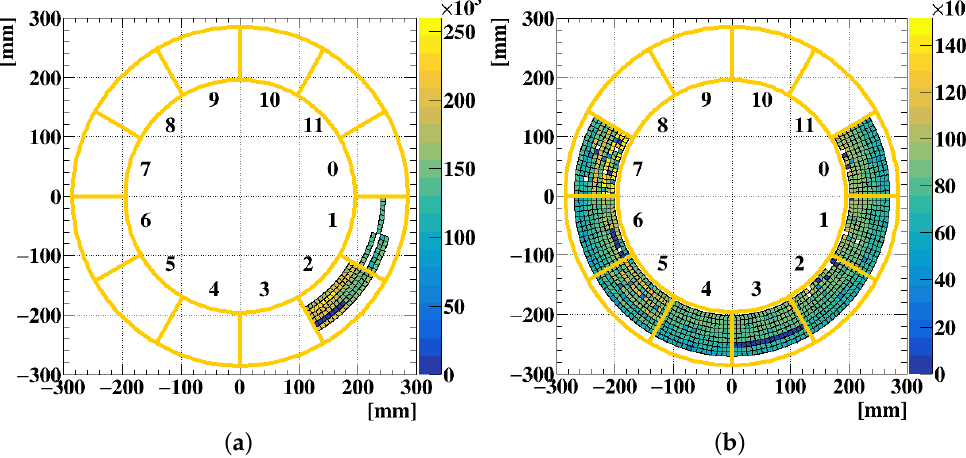
Figure 8. Occupancy plots from Michel e + events with a comparison between the 2020 ( a ) and 2021 ( b )